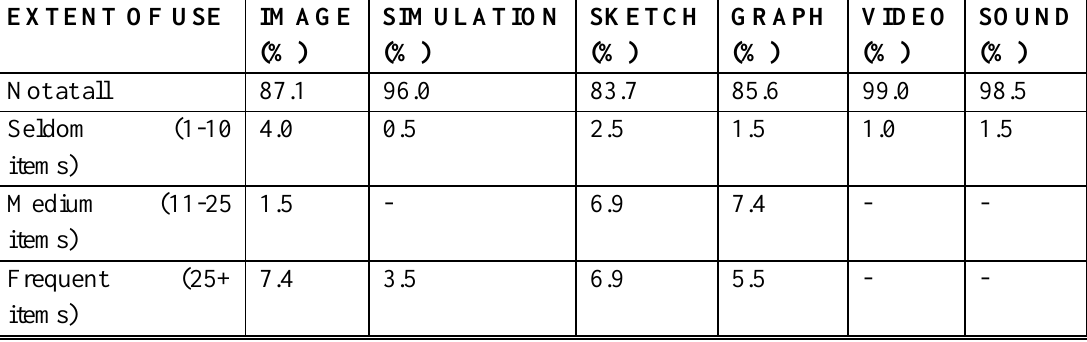
Representational Means Frequency (N = 202 Course Web sites)